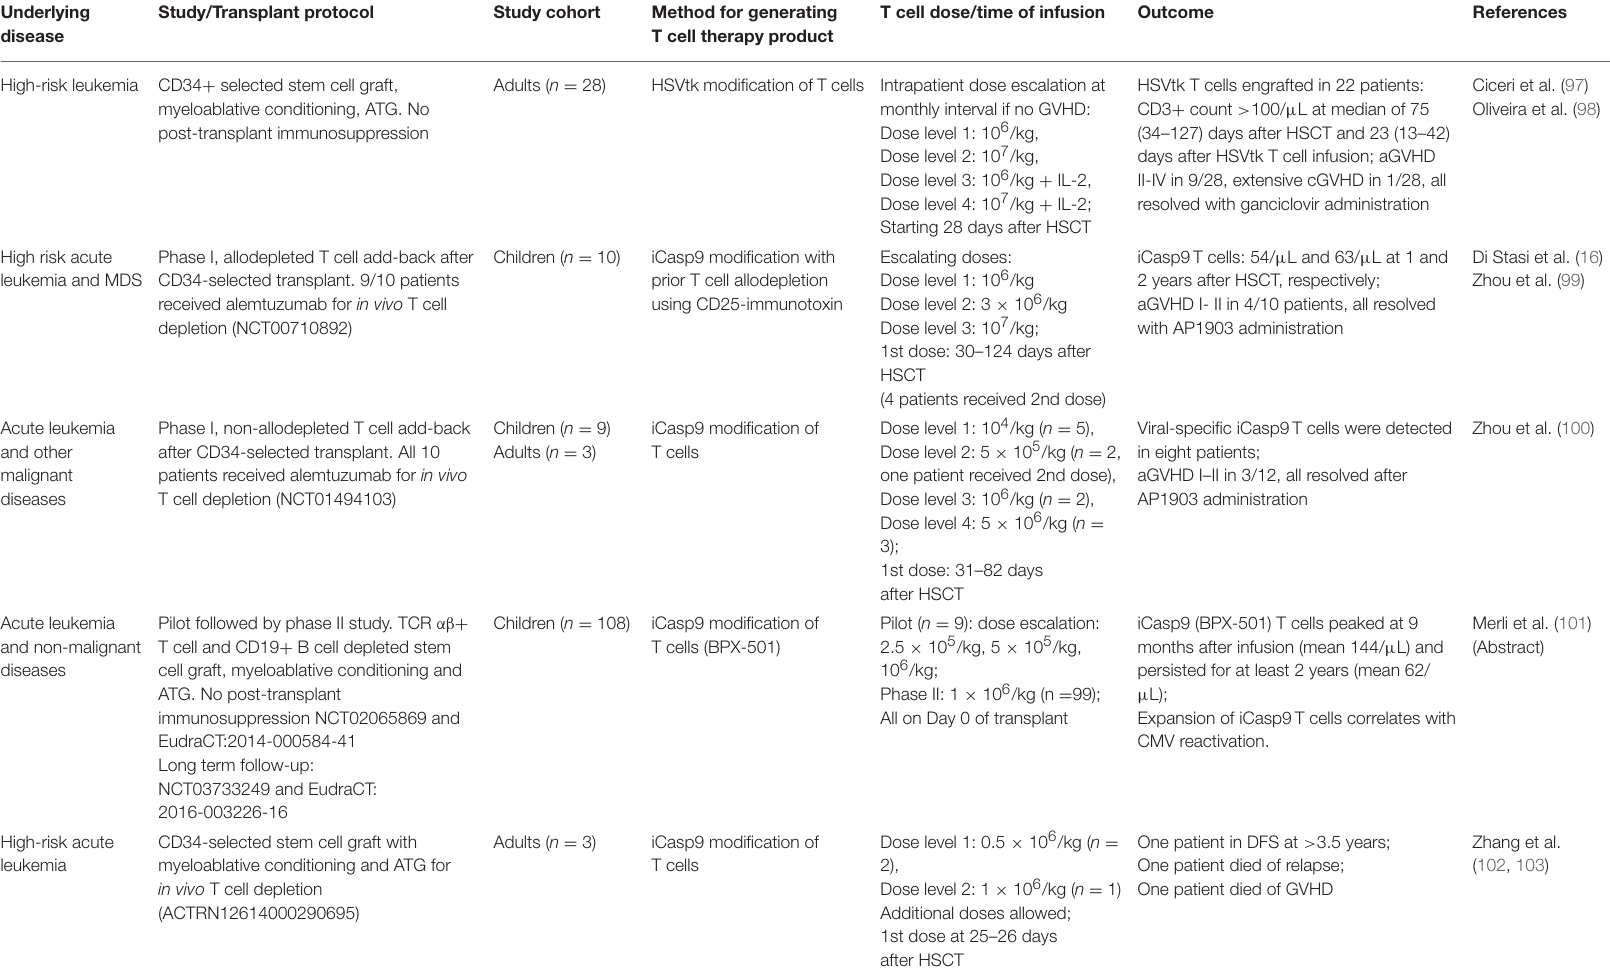
TABLE 4 | Clinical trials using safety switch gene-modified T cells after haploidentical HSCT. Underlying